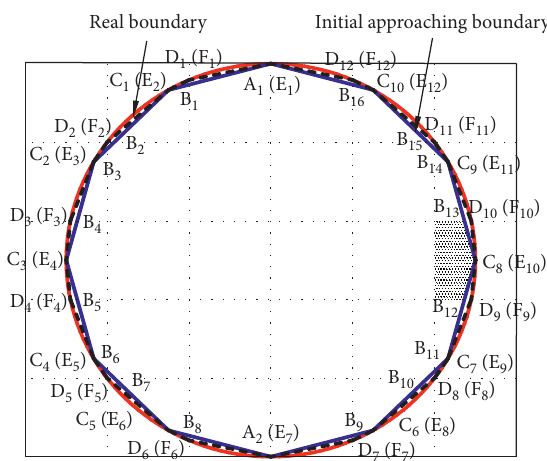
Figure 6: Relations of the initial approaching boundary, the real boundary, and rectangular meshes.